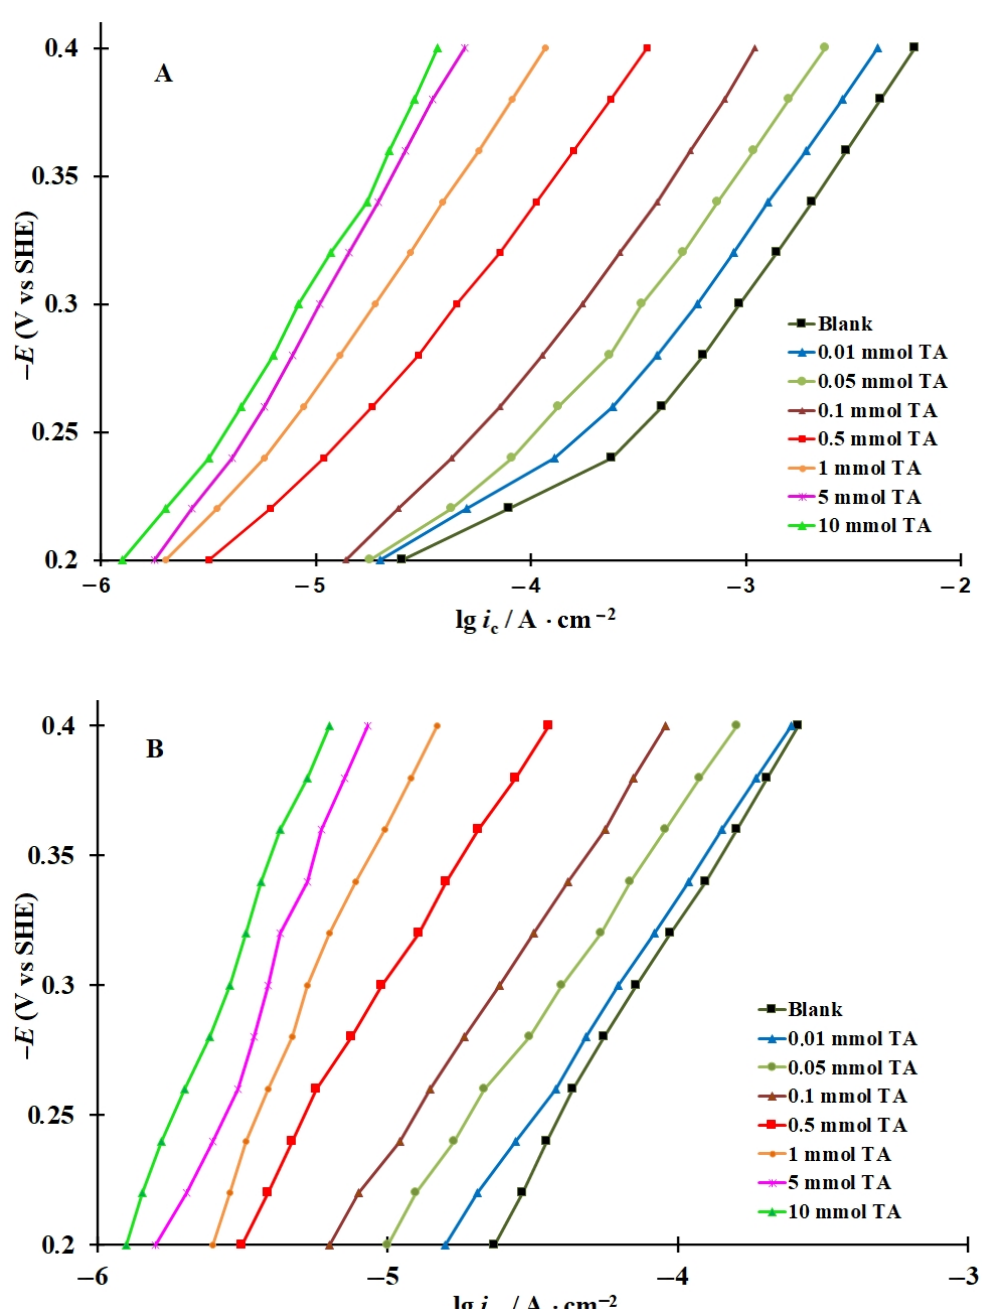
Figure 3. Cathodic polarization curves on steel ( A ) and plots of the rate of hydrogen penetration into steel vs. potential ( B ) in 2 M HCl containing TA.